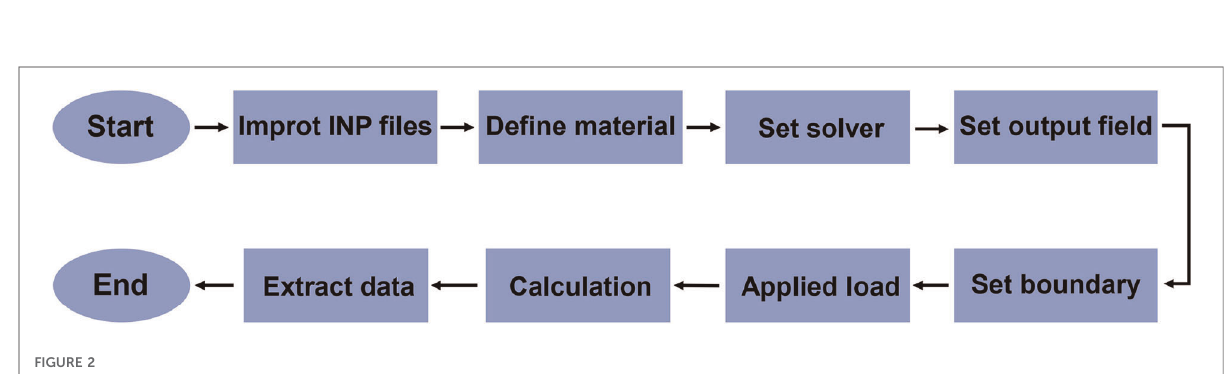
FIGURE 2 The fl owchart of whole simulation analysis